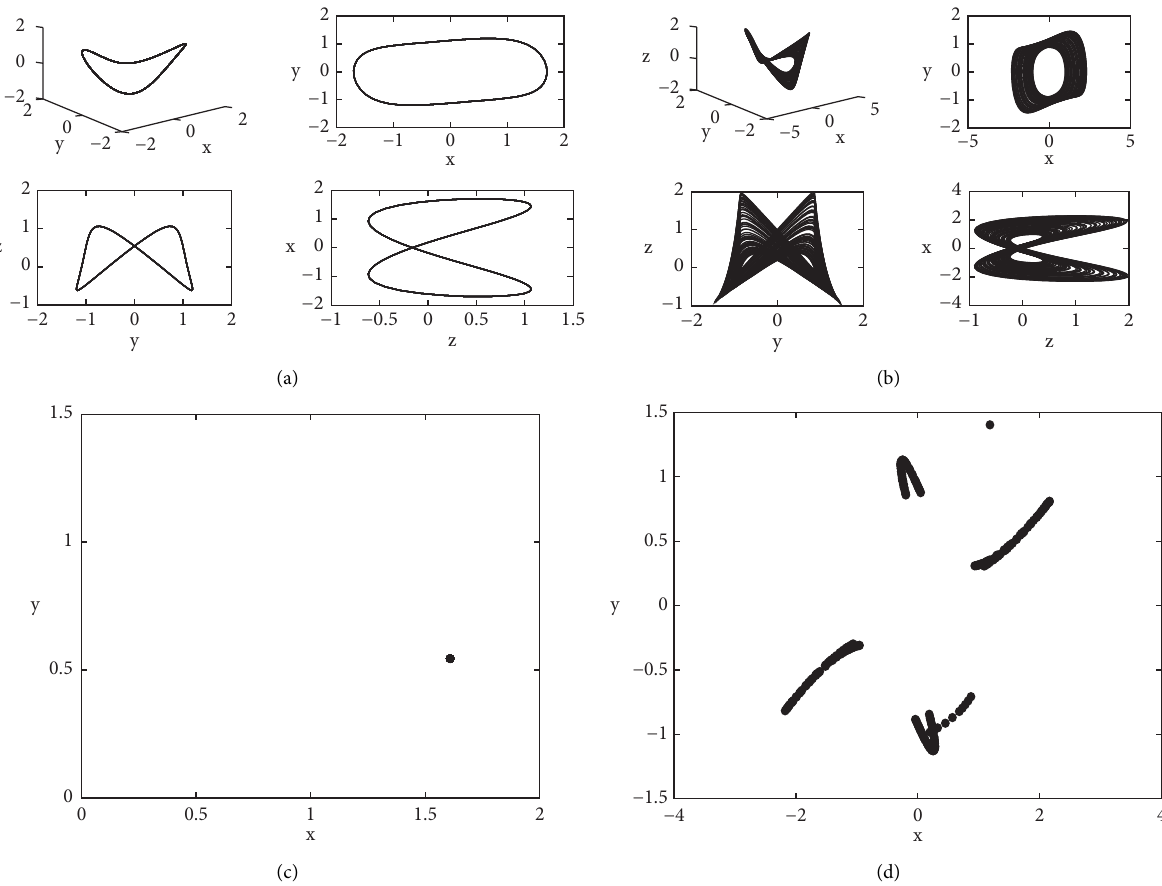
Figure 6: Phase portraits and Poincar´e section of system (1) in plane z � 0 for some special values of parameter a with constant parameters b, c, and e . (a) Periodic orbit and projection in x-y plane, y-z plane, and z-x plane. (b) Chaotic attractor and projection in x-y plane, y-z plane, and z-x plane. (c) Poincar´e section in plane z � 0. (d) Poincar´e section in plane z �